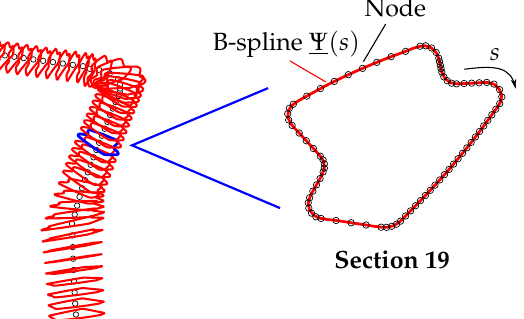
Figure 16. B-spline discretization of A-pillar.